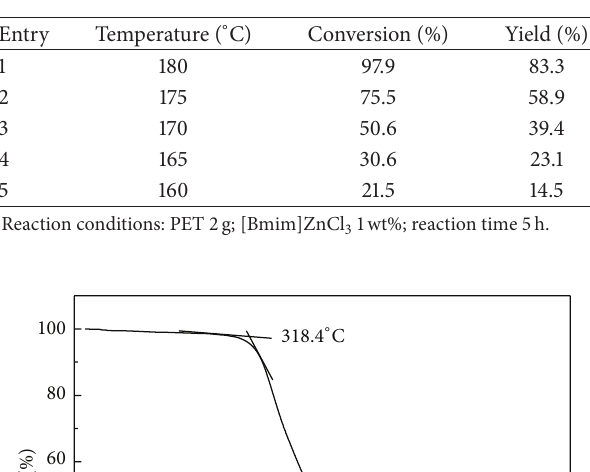
under different 3